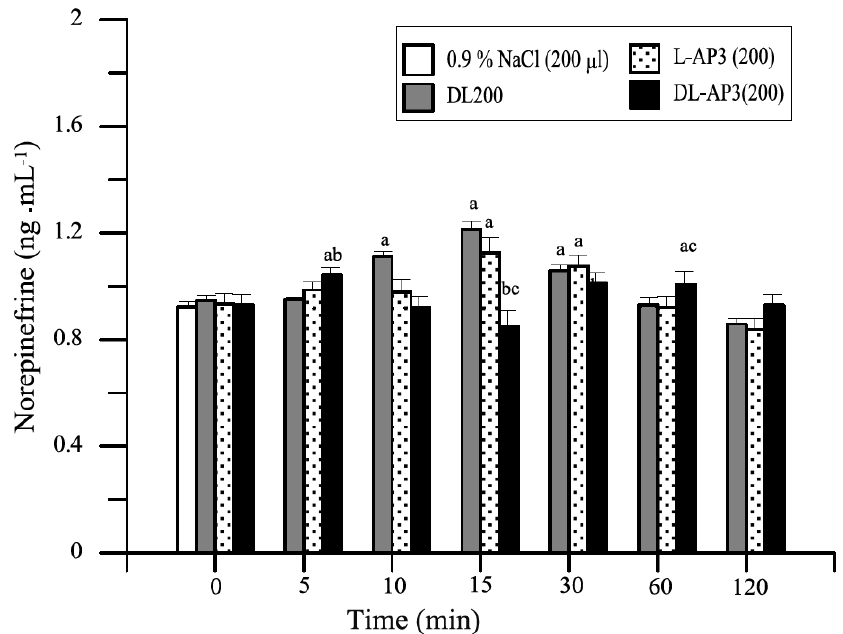
Figure 14. Summed from three doses, mean changes in plasma epinephrine levels (ng·mL − 1 ) in the test groups of animals. Control group (200 µL of 0.9% NaCl), RO200, and after 10 min (ICV infusion) premedication with three different doses of L-AP 3 (0.2, 0.4, and/or 0.8 mg in toto) and DL-AP 3 (2, 4 and/or 8 mg in toto) in the RO200 test within 120 min of completing the RO procedure (mean ± SD, n = 6) [34]. Key: a—significant differences ( p ≤ 0.05) compared with the value of 0.9% NaCl; b—significant differences ( p ≤ 0.05) compared with the value of the RO200 group; c—significant differences ( p ≤ 0.05) between the L-AP 3 and DL-AP 3 groups.